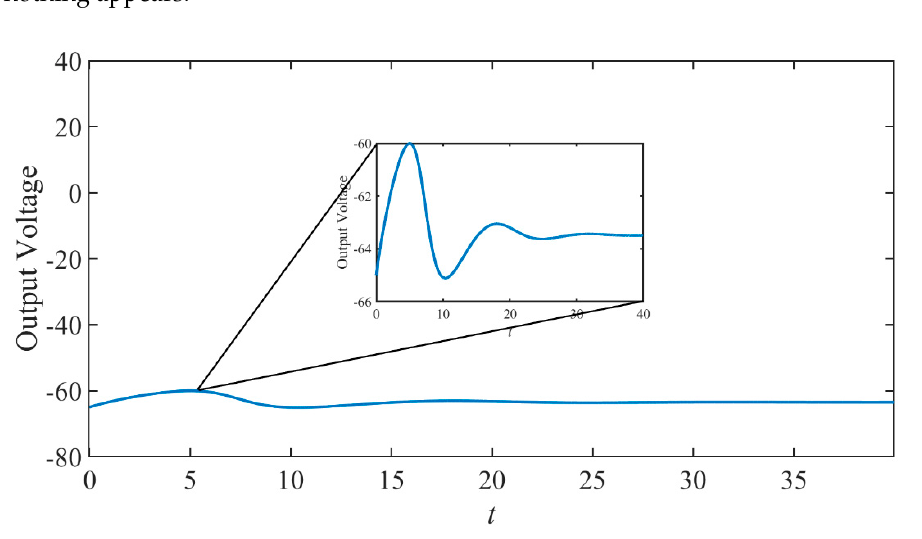
Figure 3. The response is when the input is greater than the threshold. 3. Modeling of VO 2 Local Active Memristor We adopt the Mott active memristor model and parameters of Wei Yi et al. [11]: